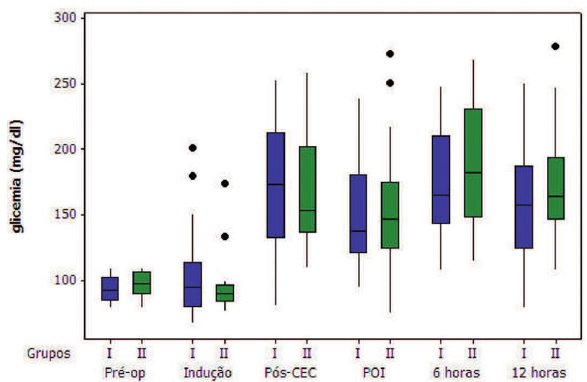
Fig. 3 - Box plot contendo os resultados dos exames de glicose sanguínea para os pacientes dos grupos I e II, nos diversos períodos coletados para